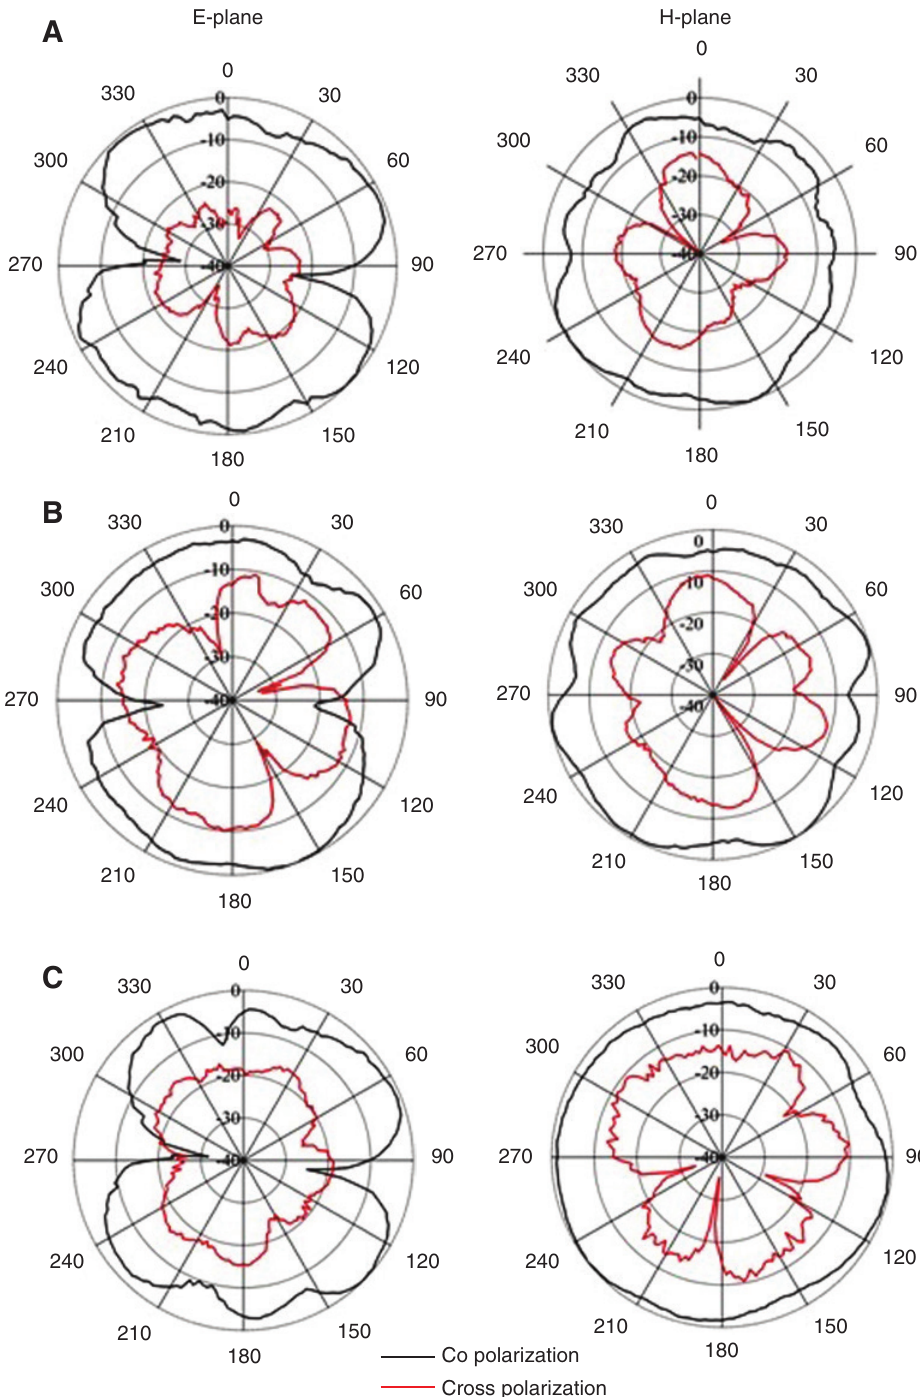
Figure 14: Measured radiation pattern of the proposed antenna at (A) 5GHz, (B) 7GHz, (C) 10 GHz.